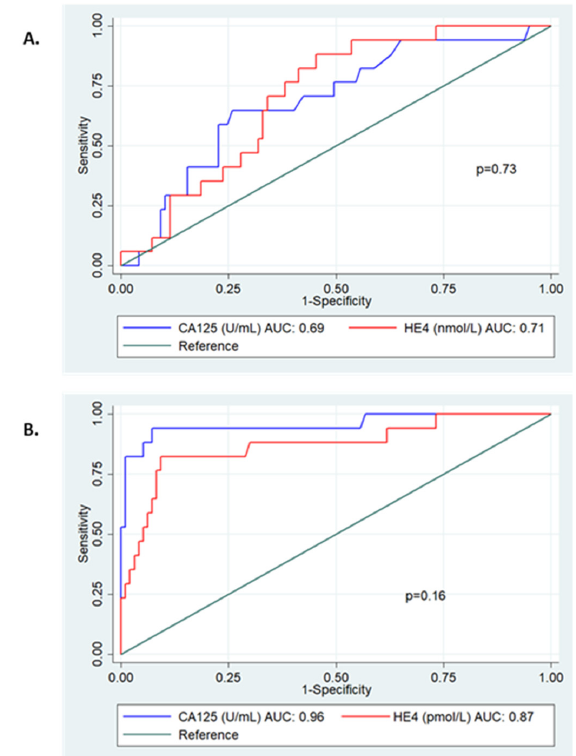
Figure 3. ROC curve analysis of serum and urine CA125 and HE4 for the detection of epithelial ovarian cancer. ( A ) Urine CA125 and HE4. CA125: AUC 0.69 (95% CI 0.55–0.82), HE4: AUC 0.71 (95% CI 0.60–0.82), p = 0.73. ( B ) Serum CA125 and HE4. CA125: AUC 0.96 (95% CI 0.89–1.00), HE4: AUC 0.87 (95% CI 0.76–0.98), p =